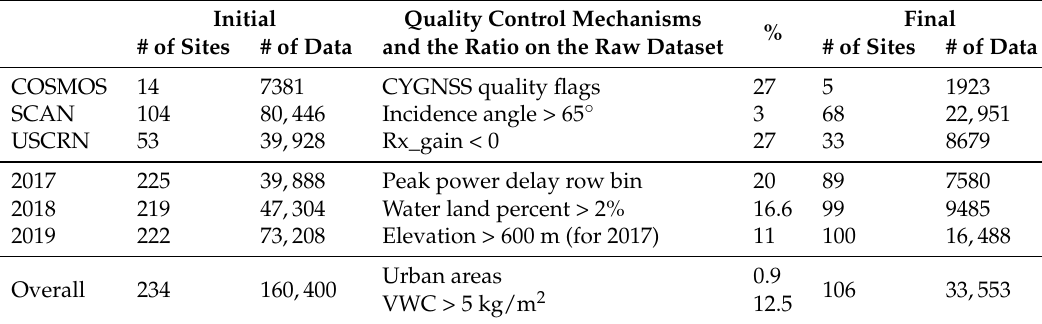
Table 1. The ISMN data statistics before and after quality control flags.